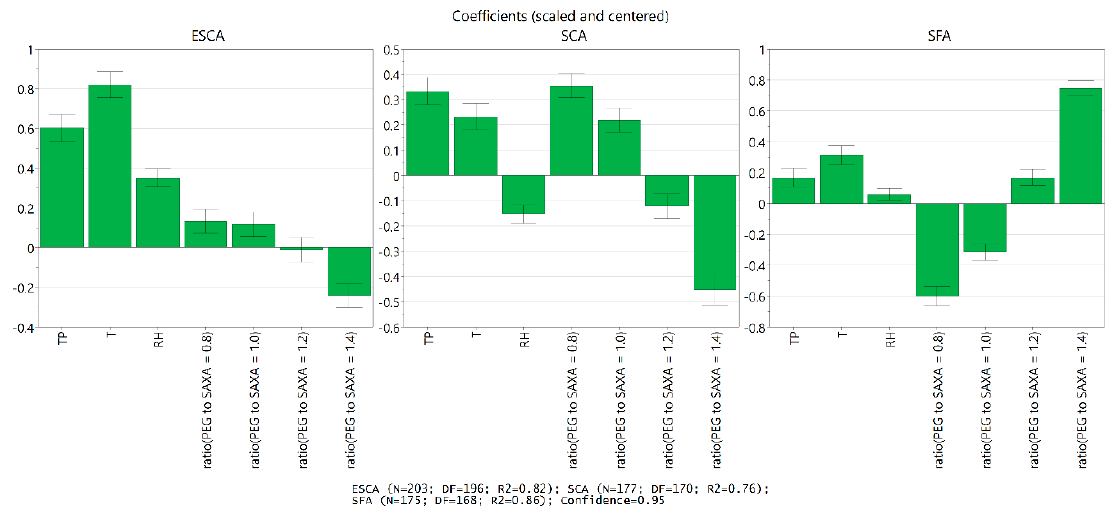
Figure 5. Scaled and centered coefficients for cyclic amidine (SCA), epimer (ESCA) and formyl amide (SFA). TP (time point), T (temperature), RH (relative humidity), and polyethylene glycol (PEG) to saxagliptin (SAXA) weight ratios 0.8, 1.0, 1.2, and 1.4.